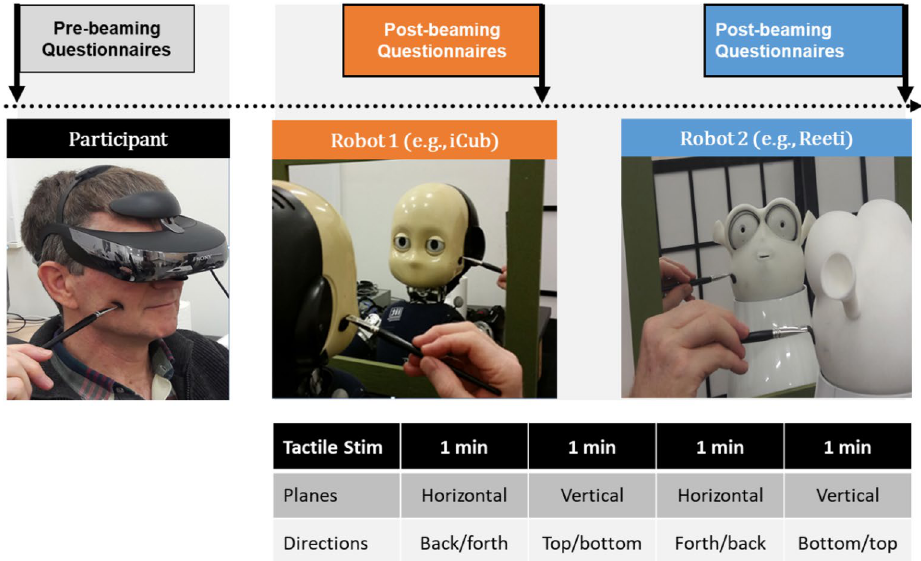
Figure 4. The robot setup illustrating (left) the human subject with head mounted display being stimulated on the right cheek, (middle) the iCub facing the mirror, stimulated on the right cheek, (right) the Reeti robot in front of the mirror, stimulated on the left cheek. Timeline indicates Pre-beaming questionnaires followed by Robot 1, Post-beaming questionnaires, then Robot 2, Post-beaming questionnaires. The panel (bottom) gives the successive 1 min phases of visuo-tactile stimulations realising one correlated or uncorrelated session of robotic telepresence. Informed Consent to publish the participant images has been obtained from study participant Jocelyne